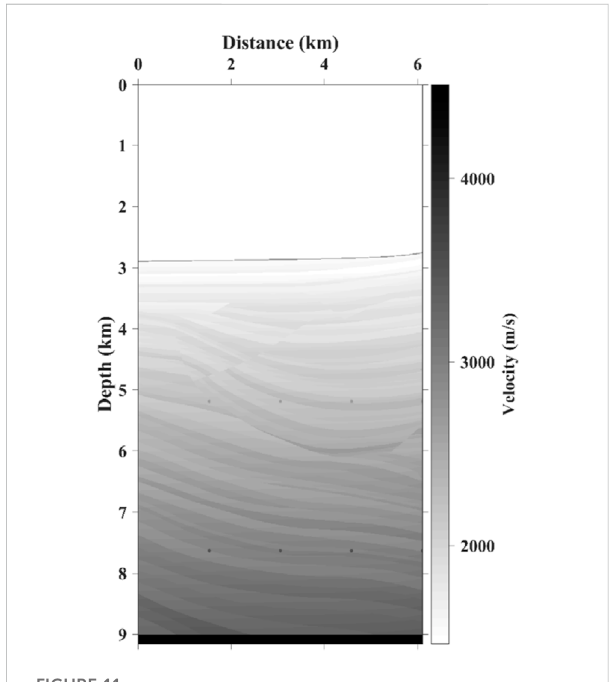
FIGURE 11 The Sigsbee2b velocity model.